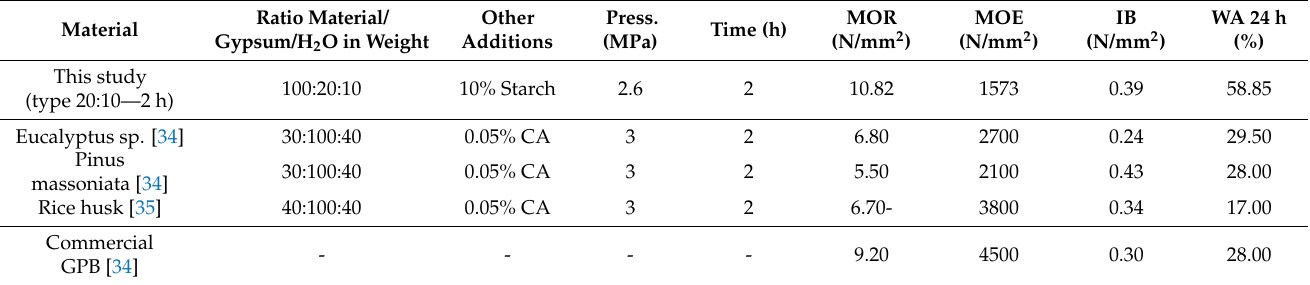
Table 5. Comparison with other particleboards made from gypsum and other lignocellulosic